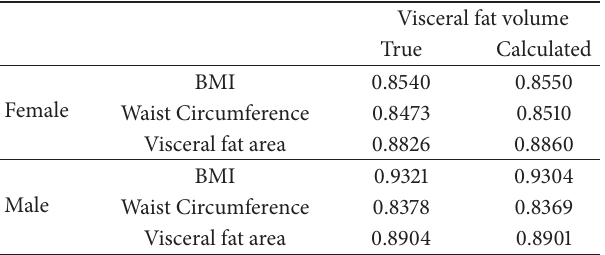
Table 2: Correlation coefficients with the substitute indices for visceral fat volume and true/calculated visceral fat